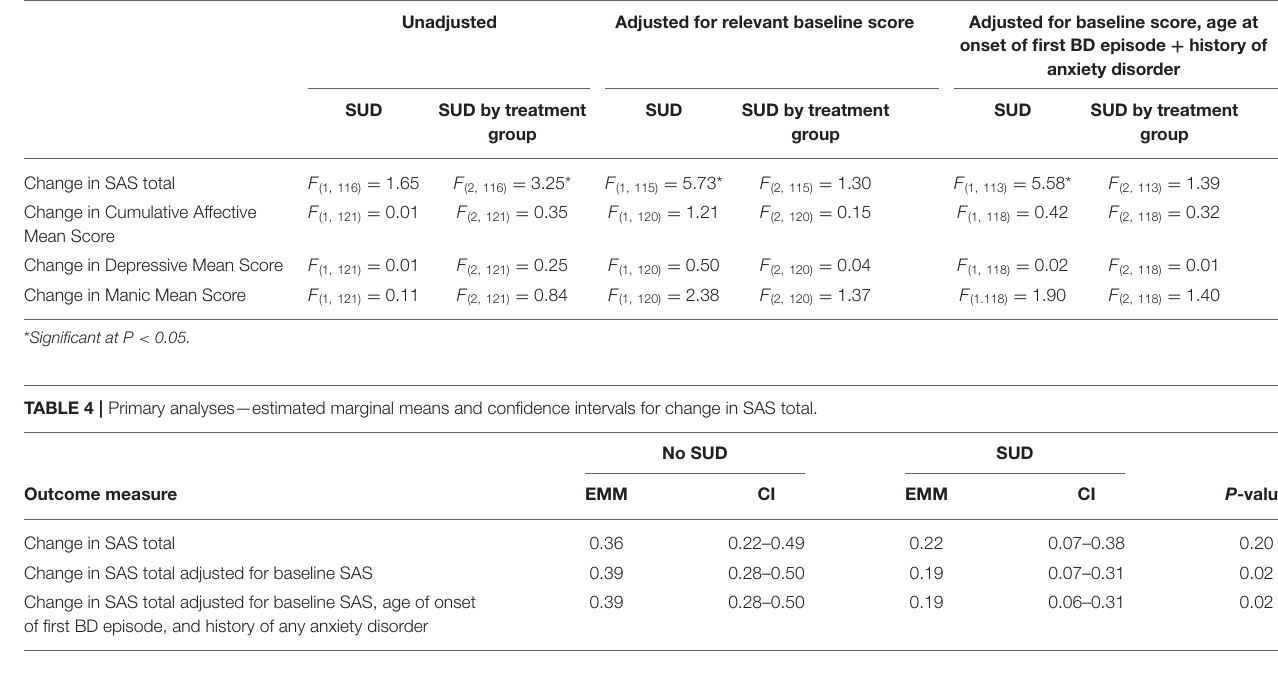
TABLE 3 | Primary analyses—univariate ANOVA based on general linear model.